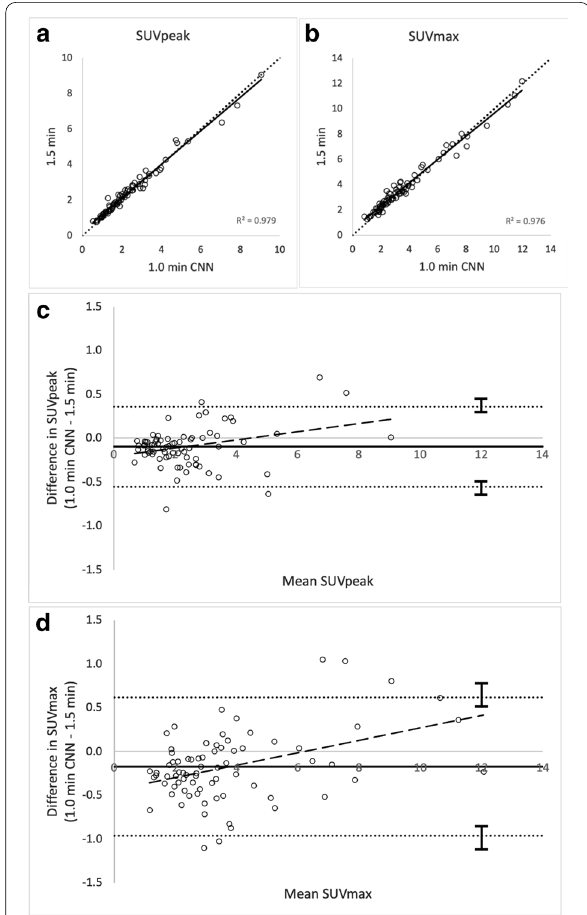
Fig. 3 Agreements and correlations between 1.5 min CNN–1.5 min image sets for SUV max , and SUV peak . Pearson correlations ( a and b ; dotted line represents the line of identity and solid line shows the linear correlation). Bland–Altman plots ( c and d ). Solid horizontal line shows the mean of differences (0.04 and 0.04, respectively). Dotted lines represent 95% limits of agreement (0.37 to to 0.55, respectively). Dashed line indicates trend. Error bars show − 95% confidence limits calculated by exact method)